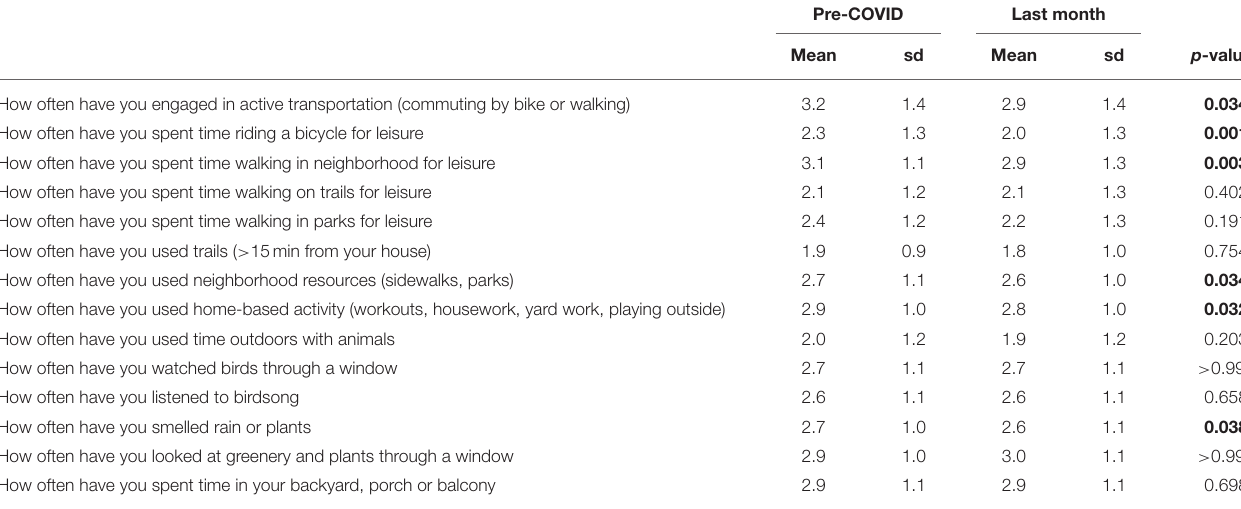
TABLE 2 | Outdoor physical activity and passive enjoyment of nature pre-COVID and during COVID.